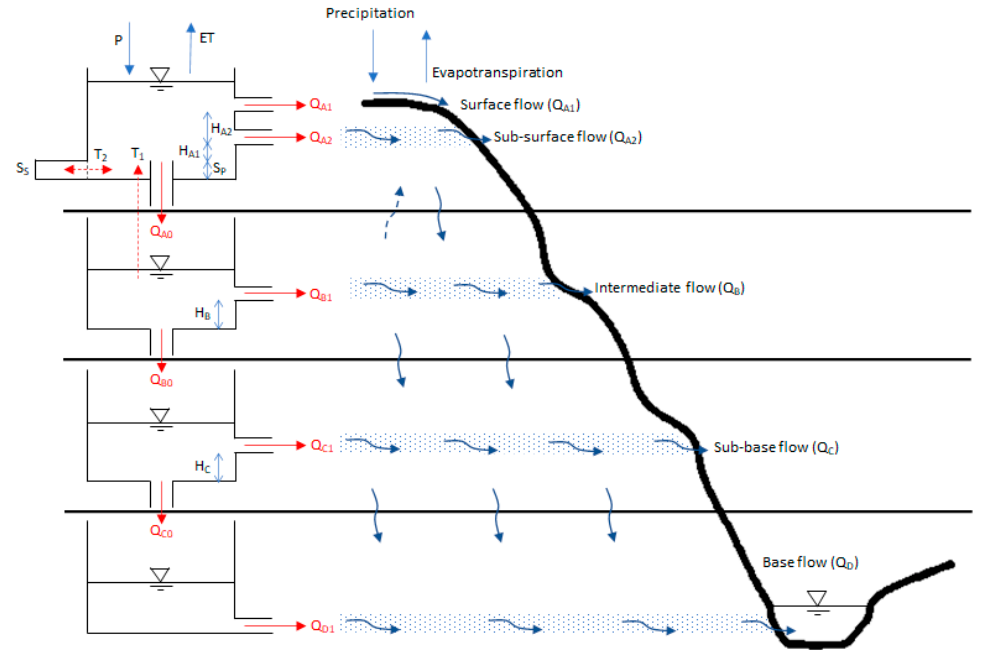
Figure 1. Conceptual rainfall-runoff model with four serially connected tanks (A, B, C and D) with soil moisture stores at the top Tank A.